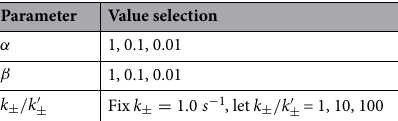
Table 2. Value selection for parameter study.